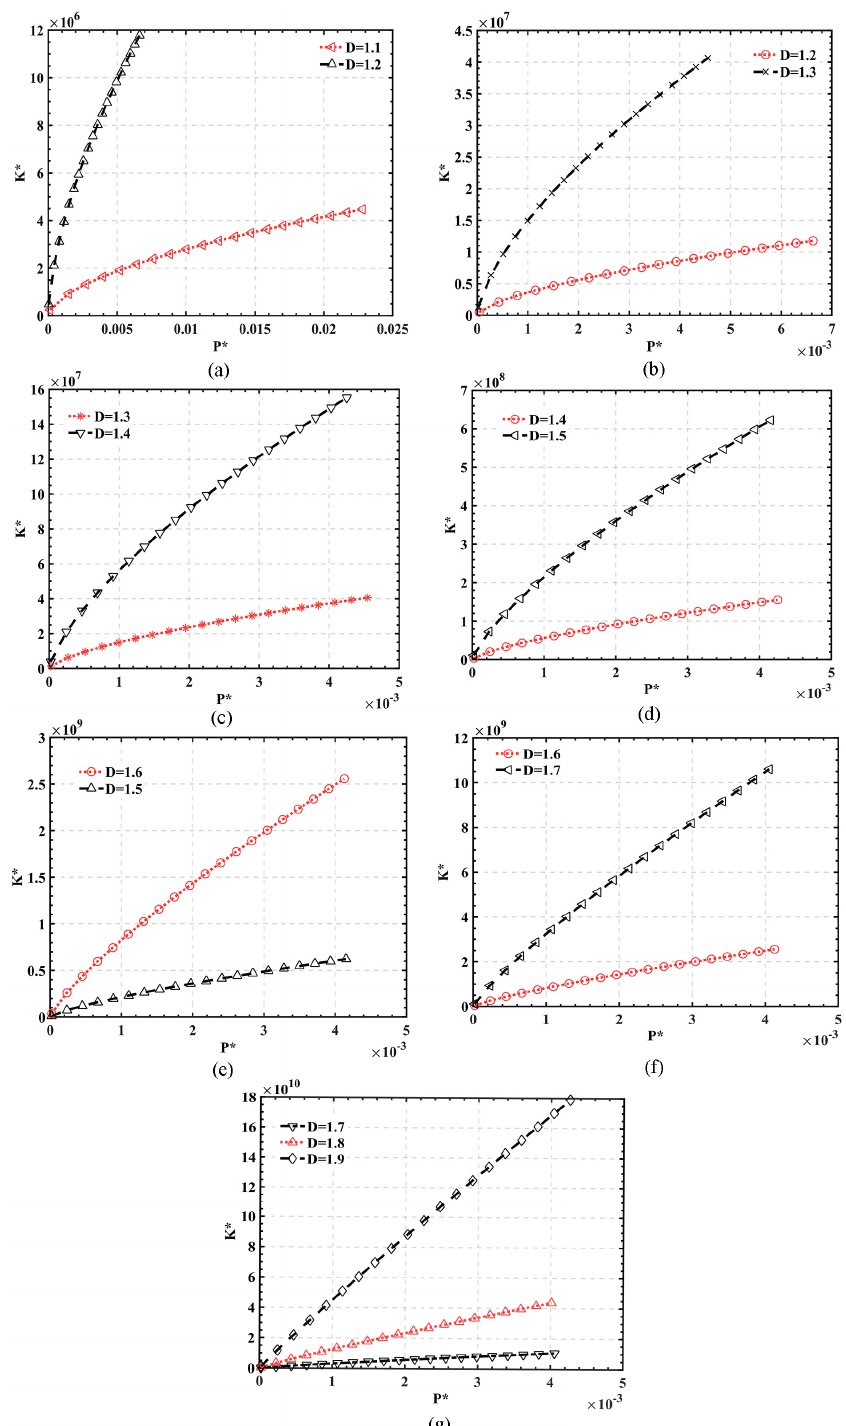
Figure 6. Influence of fractal dimensions D on P ∗ -K* curve with ∆ T ∗ = 300; ( a ) D = 1.1, 1.2 ( b ) D = 1.2, 1.3 ( c ) D = 1.3, 1.4 ( d ) D = 1.4, 1.5 ( e ) D = 1.5, 1.6 ( f ) 1.6, 1.7 ( g ) 1.7, 1.8, 1.9.